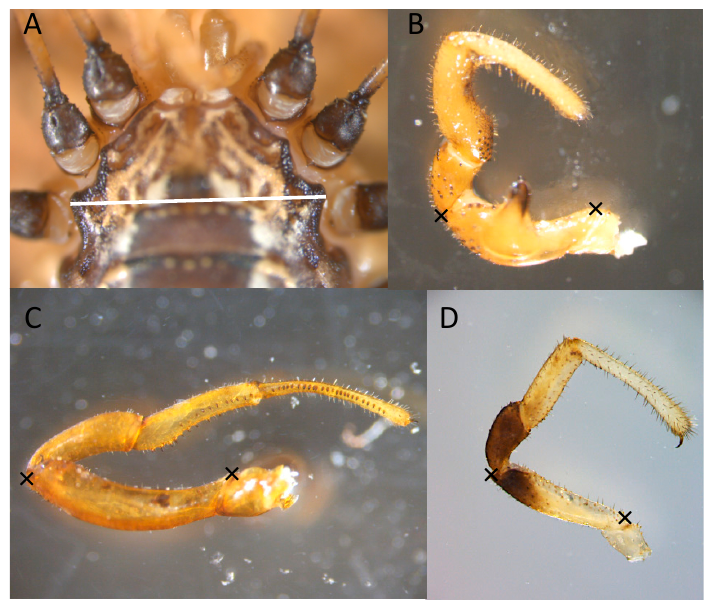
Figure 3. Morphological measurements taken of leiobunine harvestmen. ( A ) Cephalothorax width was measured at the widest point behind the second pair of legs (indicated by the white line). ( B – D ) Pedipalp length was measured as the distance on the femur between the indicated xs. The pedipalps pictured are ( B ) L. calcar , ( C ) L. vittatum , and ( D ) L. aldrichi .